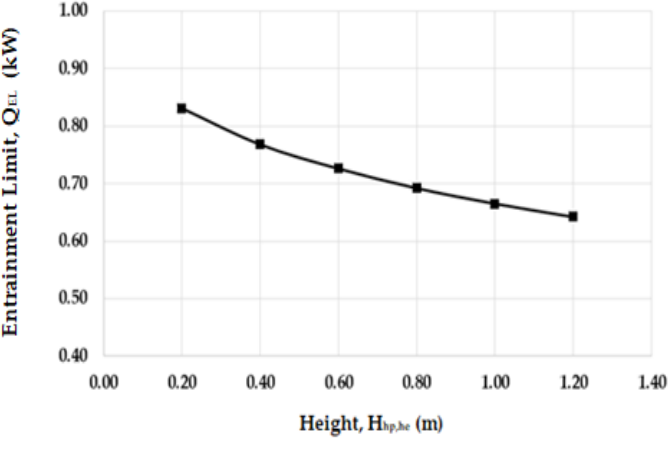
Figure 5. Impact of the height H hp,he on the entrainment limit.